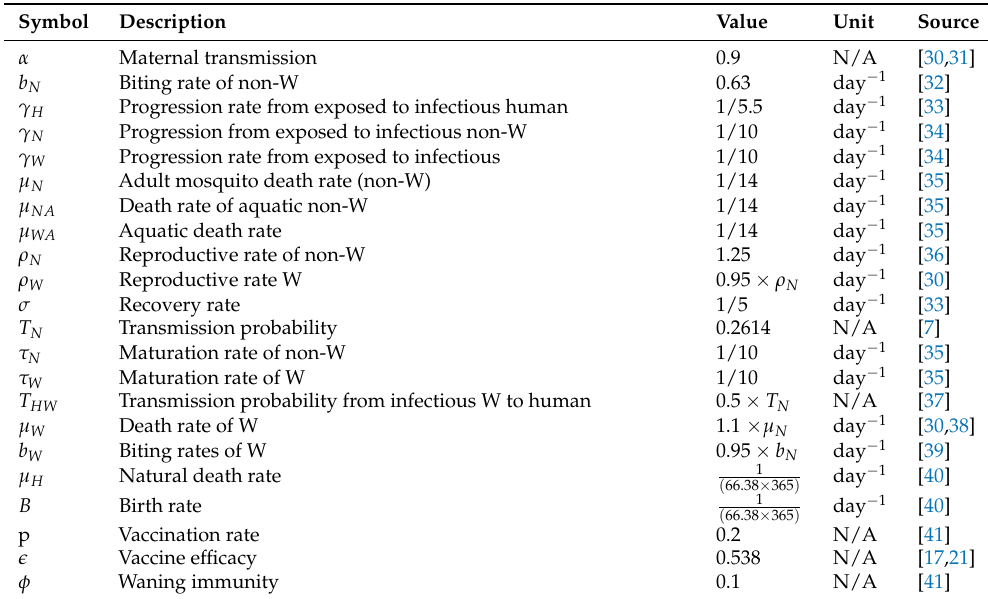
Table 1. Parameter descriptions, values and sources for the model. We use “Non-W” to denote non- Wolbachia mosquitoes and “W” to denote Wolbachia -carrying mosquitoes.